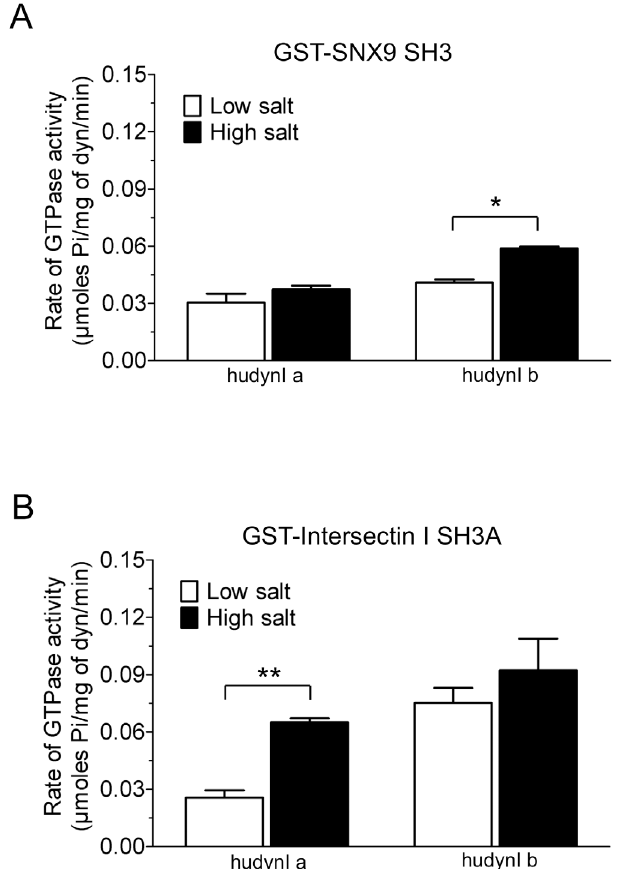
Fig 3. Effect of salt on the stimulation of dynamin I middle domain splice variants by GST-SNX9 SH3 and GST-intersectin I SH3A. Statistical analysis by two-way ANOVA followed by Bonferroni ’ s post-test shows GST-SNX9 SH3 (A) and GST-intersectin I SH3A (B) elicit a greater rate of GTPase activity in the presence of high salt for both splice variants. All data shown is ± S.E.M. with n (cid:1) 2 ( * , p < 0.05 and ** , p <